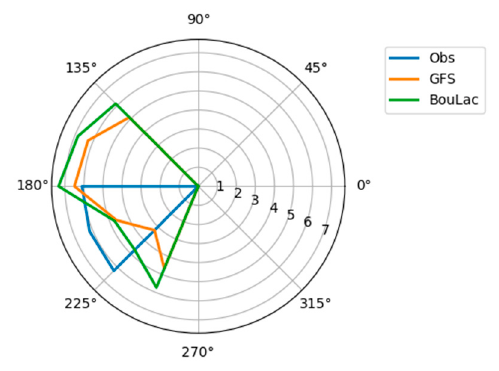
Figure 7. Wind field comparison chart. The observed wind speed is 5–10 m·s − 1 , and the height is 100–300 m on the 24th–25th (sunny days).